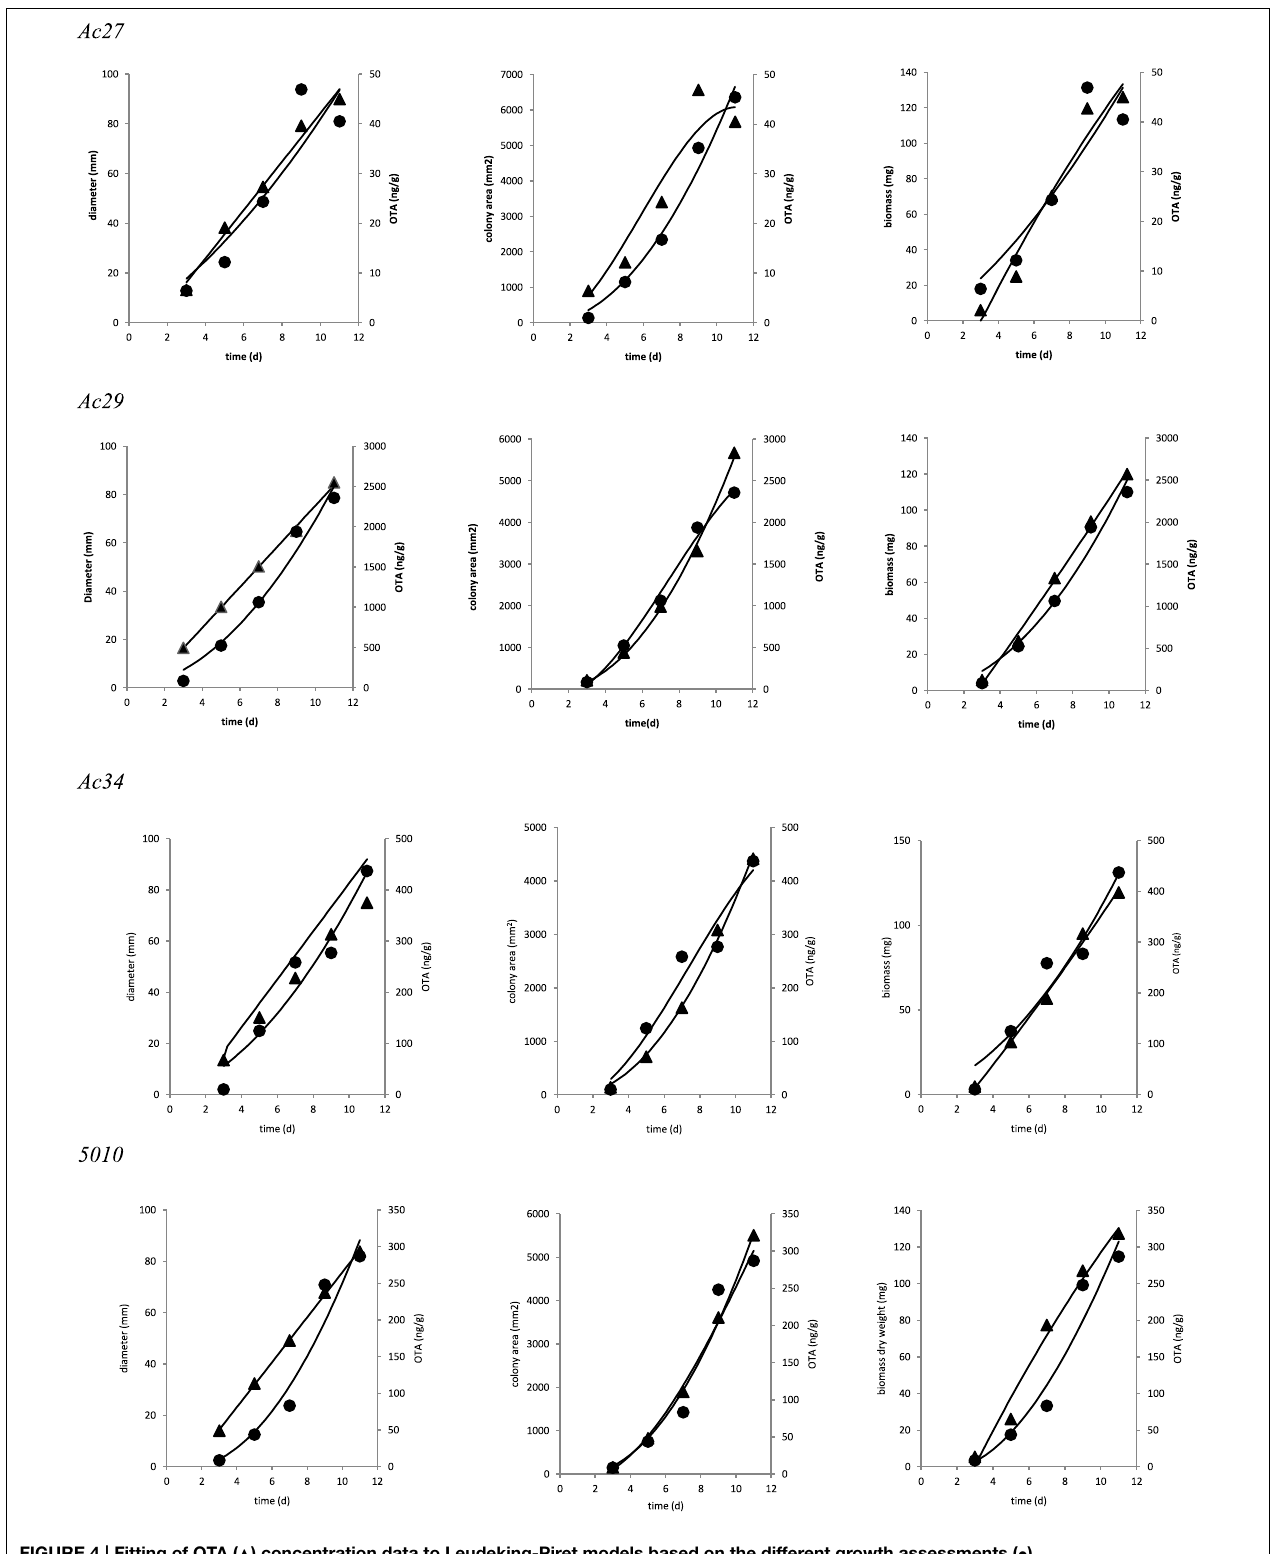
FIGURE 4 | Fitting of OTA ( N ) concentration data to Leudeking-Piret models based on the different growth assessments ( • ).